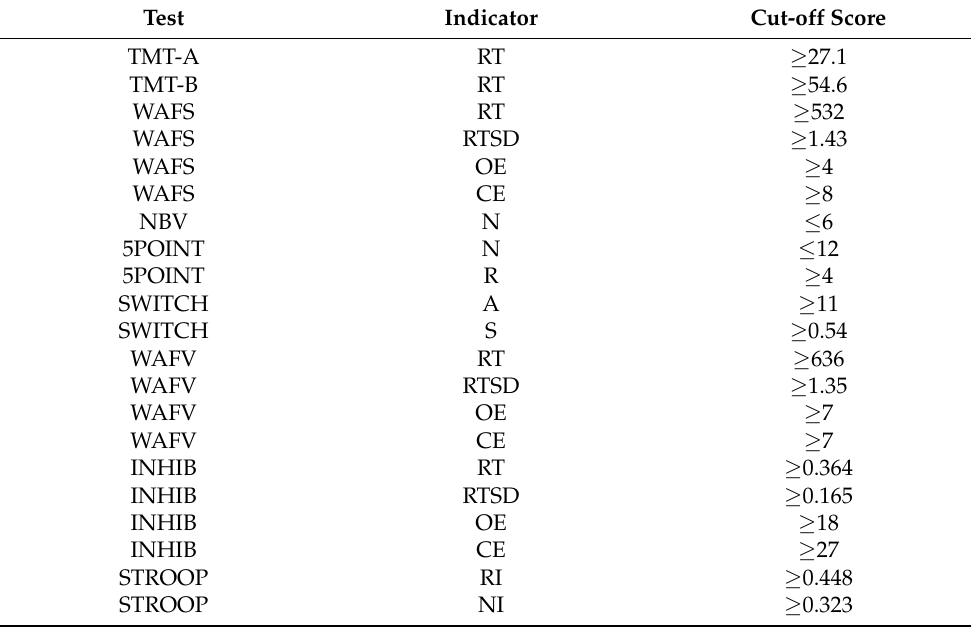
Table 3. Cut-off